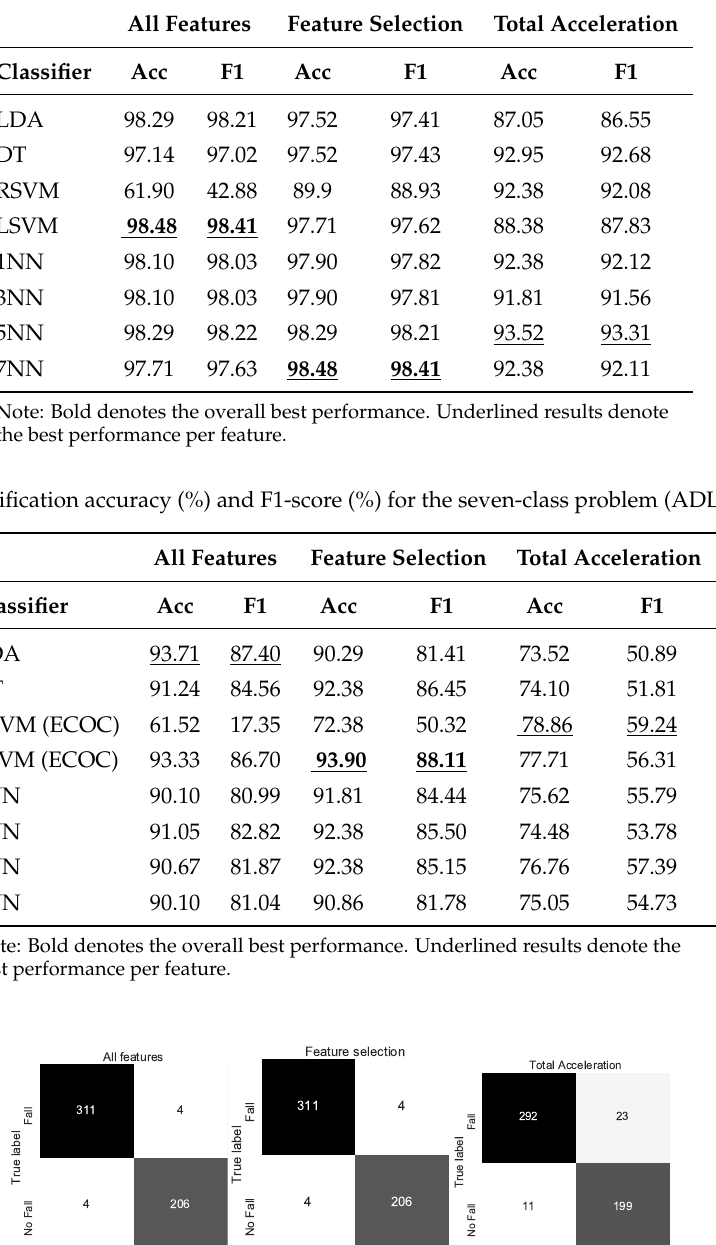
Table 2. Classification accuracy (%) and F1-score (%) for the binary problem ( Fall / No Fall ).